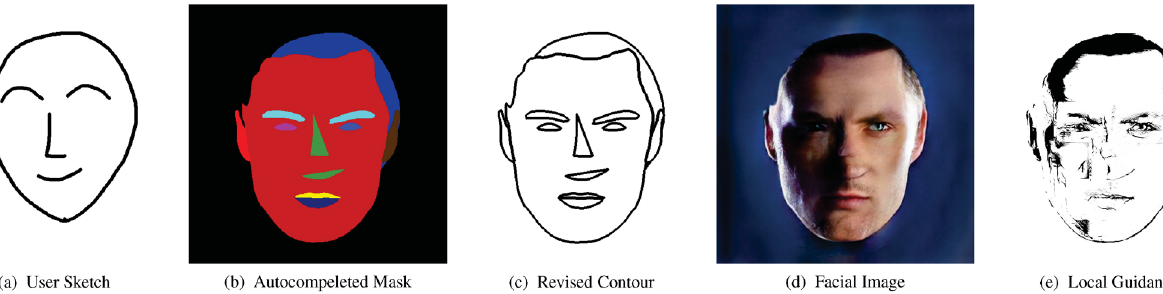
Fig. 12 Limitations of our work. An abstract sketch may not be converted to a reasonable mask (b): the mouth in the user’s contour sketch (a) is wrongly regarded as a part of the nose. This caused degeneration of the generated image (d) and local guidance